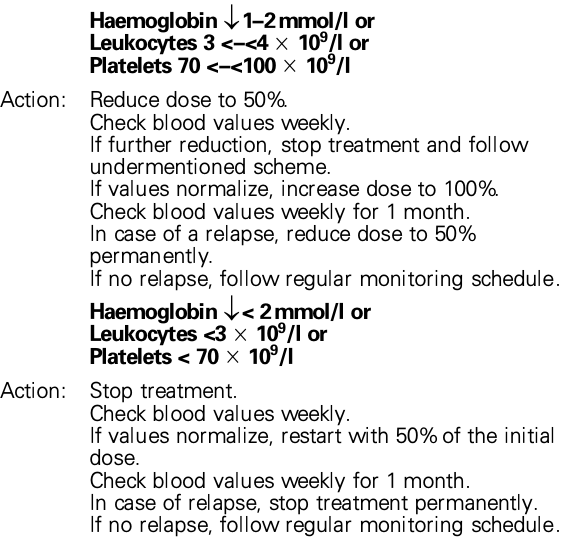
Table 1. Monitoring schedule azathioprine/6-mercaptopurine treatment for IBD First 3 months: haemoglobin, leukocytes, platelets every 2 weeks, followed by Haemoglobin, leukocytes, platelets every 2